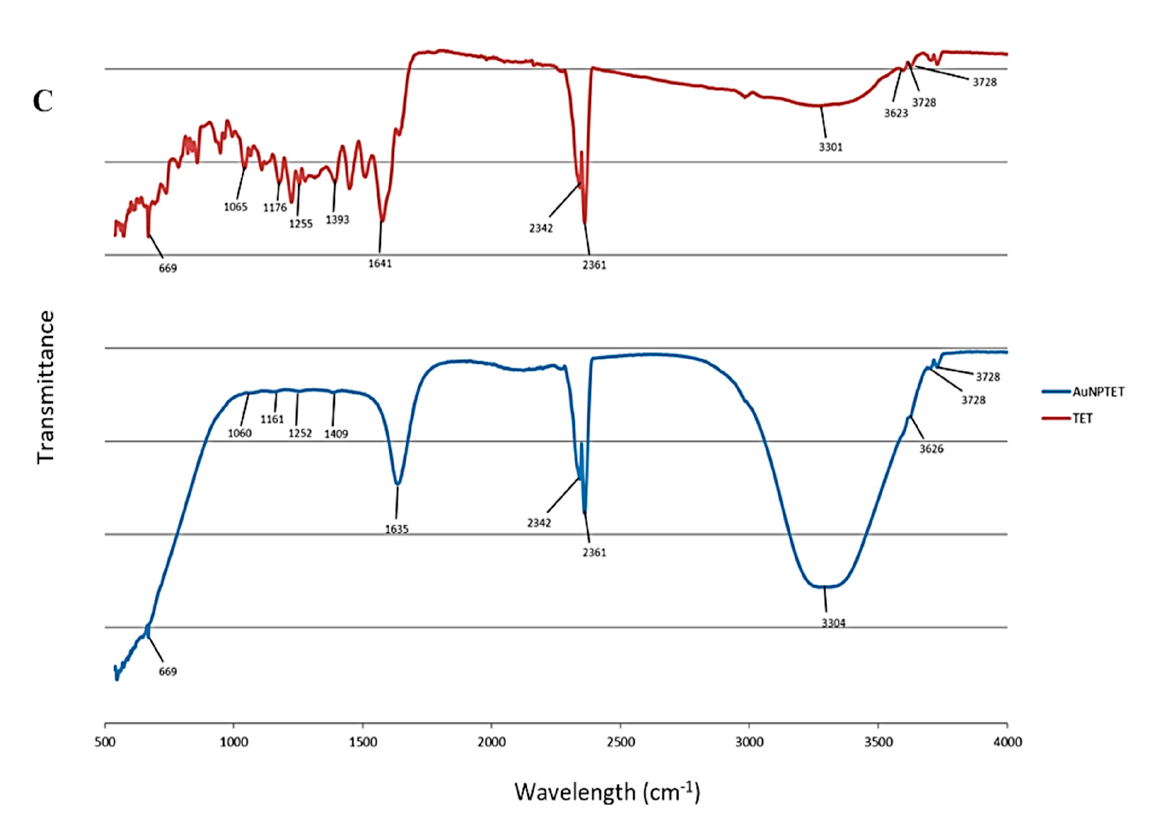
Figure 1. Fourier transform infrared spectra for ( A ) Plectranthus aliciae ethanolic extract (PAE) and Plectranthus aliciae ethanolic extract gold nanoparticles (AuNP PAE ); ( B ) rosmarinic acid (RA) and rosmarinic acid gold nanoparticles (AuNP RA ); ( C ) tetracycline (TET) and tetracycline gold nanoparticles (AuNP TET ).